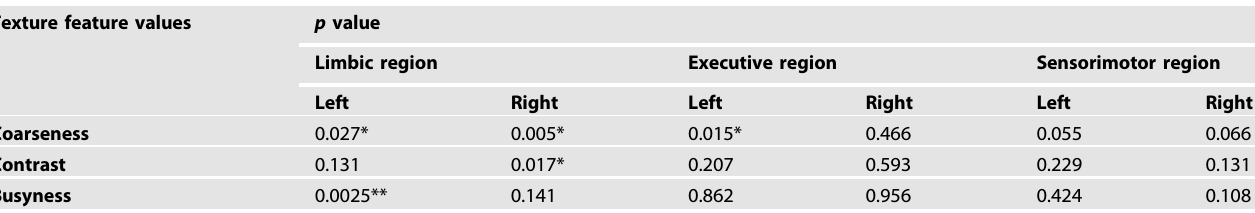
Table 2. Texture feature values and the severity of depression.